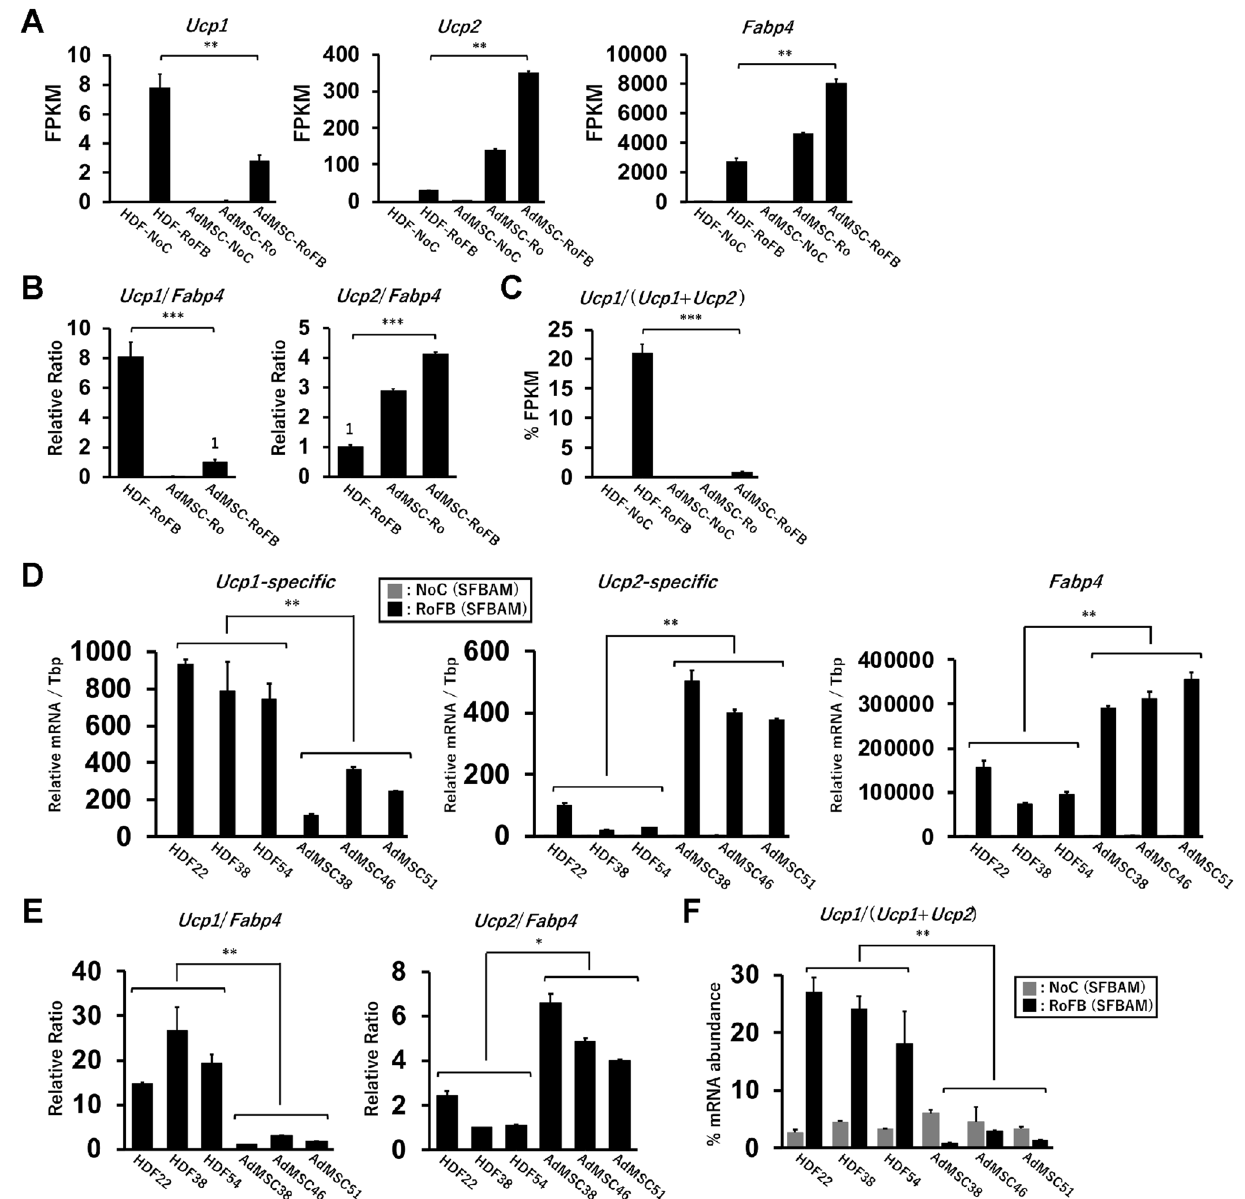
Figure 6. Transcriptional analysis of Ucp1 and Ucp2 in ciBAs and AdMSC-derived adipocytes. ( A ) FPKM values in Ucp1 , Ucp2 , and Fabp4 were obtained from the RNA-Seq data. ( B ) The ratios of Ucp1 and Ucp2 FPKM to Fabp4 FPKM are represented. ( C ) Percent FPKM values of Ucp1 in Ucp1 and Ucp2 mRNAs were calculated. ( D ) The expression of Ucp1 , Ucp2 , and Fabp4 was quantified by qRT-PCR in ciBAs converted from three different lines of human dermal fibroblasts and adipocytes differentiated from three different lines of AdMSCs under the same culture condition. The PCR primers for Ucp1 and Ucp2 were designed to selectively amplify each mRNA. Grey bars indicate the control with SFBAM only, while black bars indicate the results of either ciBAs or the AdMSC-derived adipocytes induced with RoFB in SFBAM. ( E ) The ratios of Ucp1 and Ucp2 mRNA to Fabp4 mRNA are represented. ( F ) Percent mRNA abundance of Ucp1 in Ucp1 and Ucp2 mRNAs was calculated by using DNA templates whose copy numbers were calculated for the quantification. Data represent mean ± SD (n = 3). Student’s t-test: *P < 0.05, **P < 0.01, ***P <